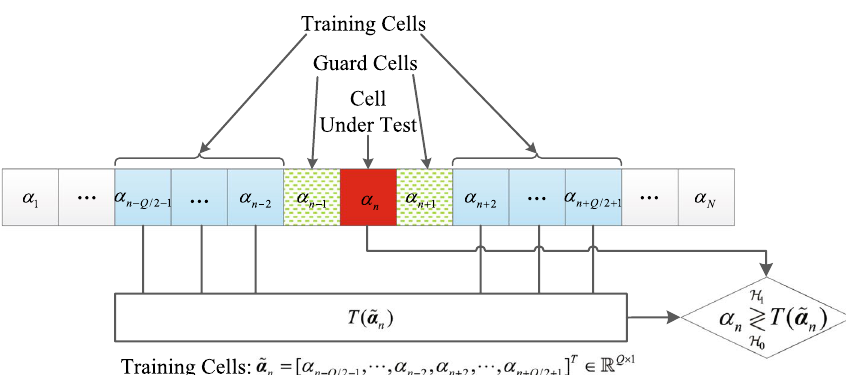
Fig. 3 Block diagram of CFAR